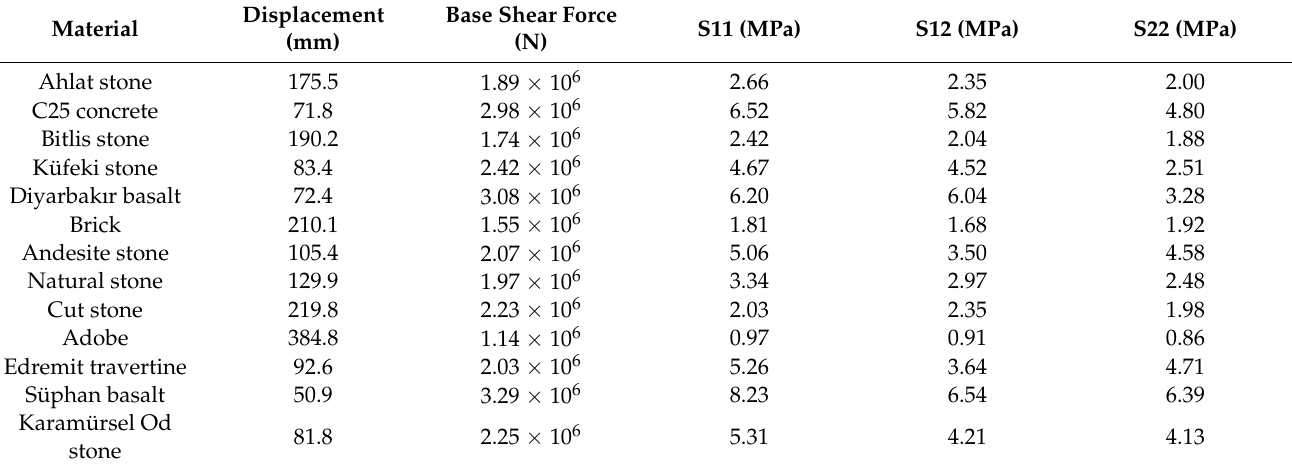
Table 13. Comparison of the analysis results for different material types (H = 25.40 m).